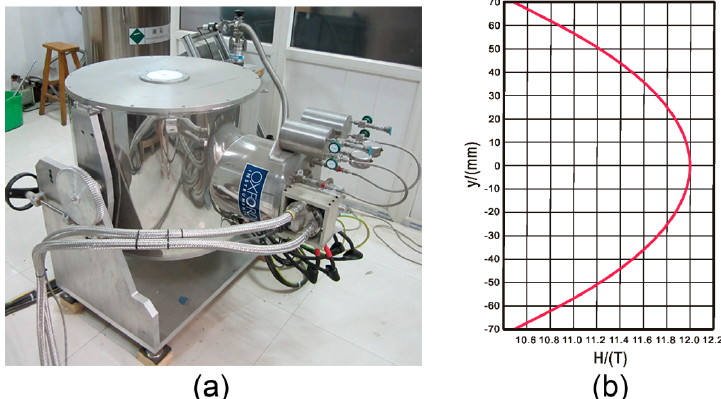
Figure 2. Setup used for high-throughput crystallization: ( a ) the front view of the transverse magnet; and ( b ) the magnetic flux density over ±70 mm at full field.